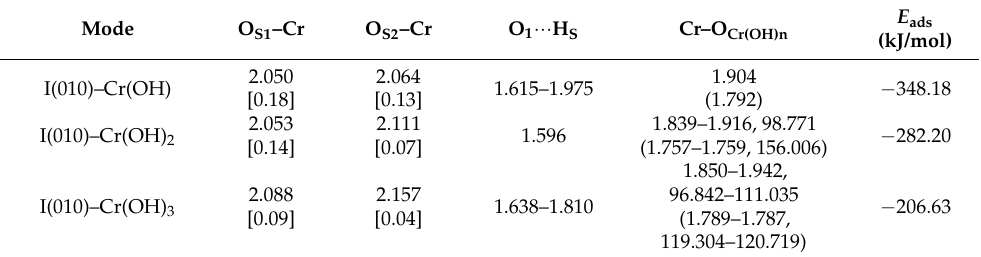
Table 2. Calculated energy characteristics (kJ/mol) and structural parameters (Å) of Cr(OH) n(3 − n)+ adsorbed on the illite (010) surface.